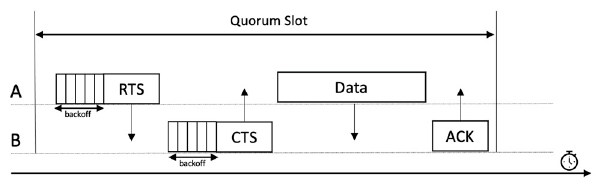
Figure 12. RTS/CTS/DATA/ACK dialog. Table 1. Simulation parameters.